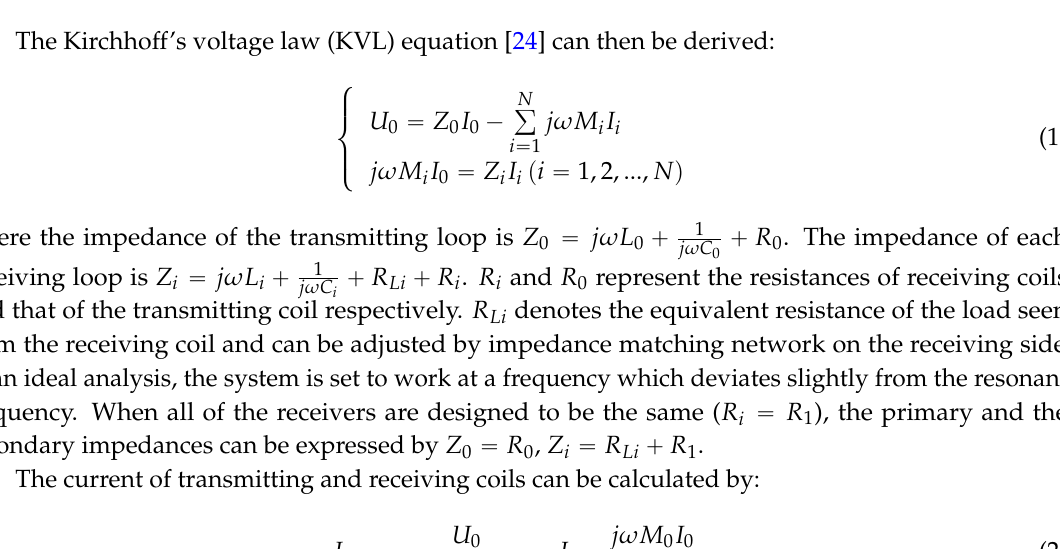
Figure 2. Equivalent circuit of an on-road charging system.